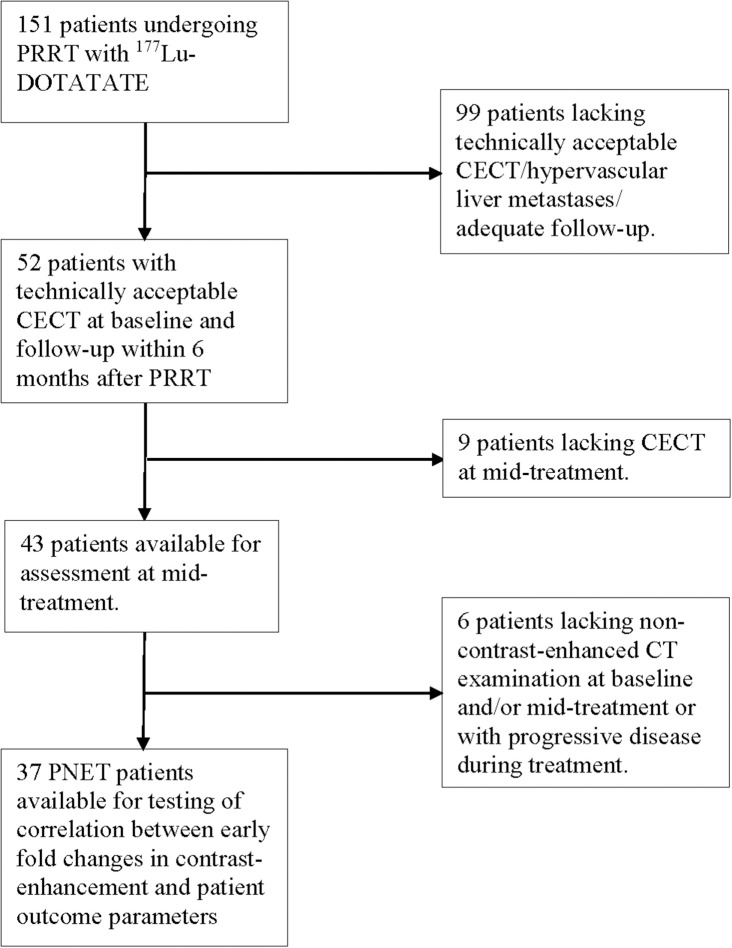
Flow chart depicting the number of PNET patients included for the different evaluations.